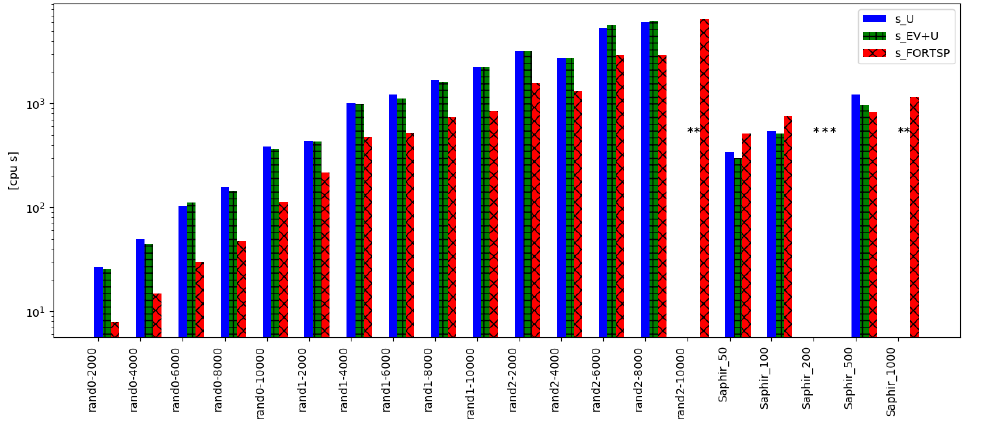
Figure A3. Cumulative solution time of scenario instances in BD, where **, *** means the algorithm fails to solve the instance in 10,800 CPU